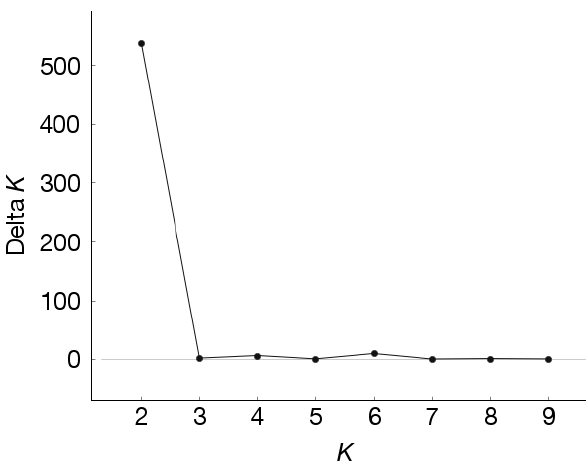
Figure A2. Relationships between pairwise genetic distances, F ST /(1 − F ST ), and the geographic distance separating 22 Thujopsis populations.